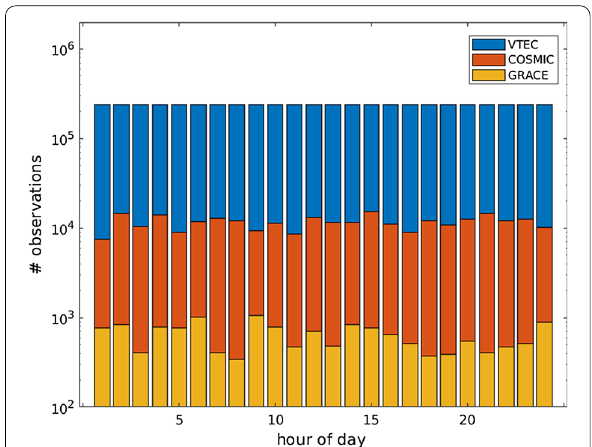
Fig. 5 Number of electron density observations N e = N e ( x GRACE ) from GRACE, N e = N e ( x F3C ) from the F3C mission and N e = N e ( x SA ) from the separability approach during the time interval March 12, 00:00 UT to 24:00 UT,